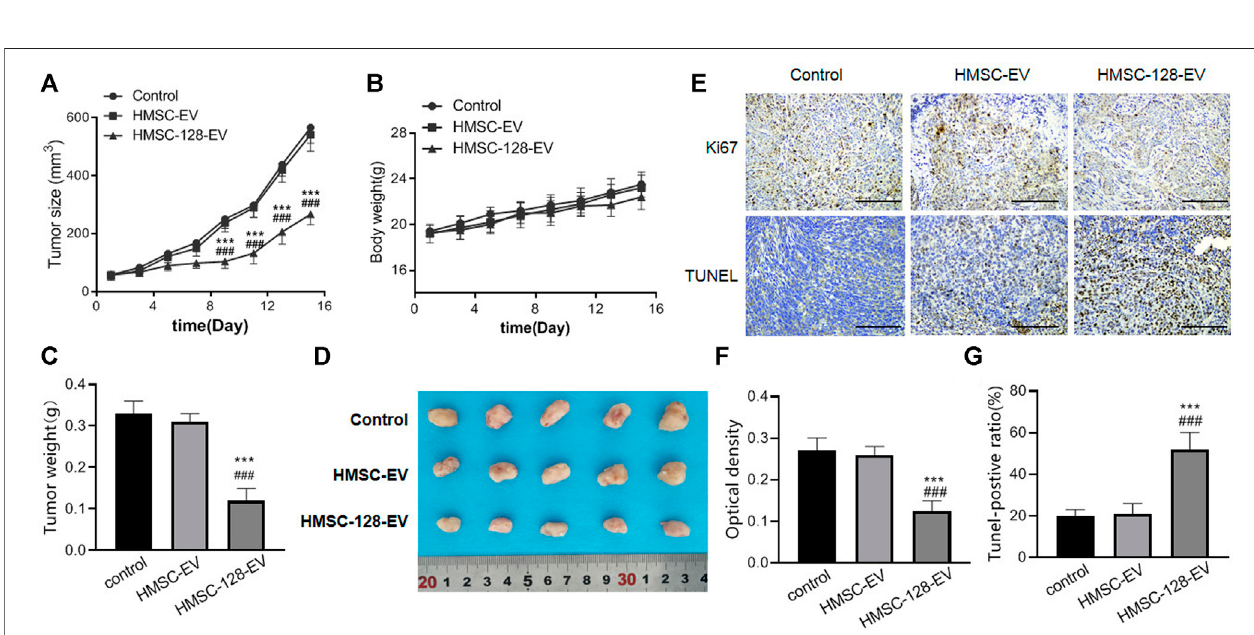
FIGURE7| HMSC-128-EVinhibitedEMTofBUCT24. (A) isthetypicalpictureofwesternblottingofE-cadherin,N-cadherin,beta-catenin,andVimentin. (B) isthe statisticalresultsofwesternblottingofE-cadherin,N-cadherin,Beta-catenin,andVimentin.HMSC-128-EVsigni fi cantlyinhibitedN-cadherin,Beta-catenin,andVimentin expression and promoted E-cadherin expression. *** p < 0.001 vs. Control, ### p < 0.001 vs. HMSC-128-EV.